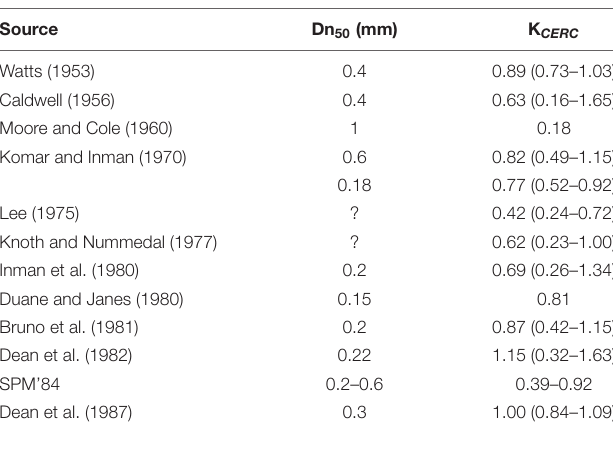
TABLE 1 | Average values proposed by different authors for K CERC and experimentally determined variation intervals (in parenthesis), modified after Soulsby (1997), where Soulsby’s book includes all references under the “Source” column.